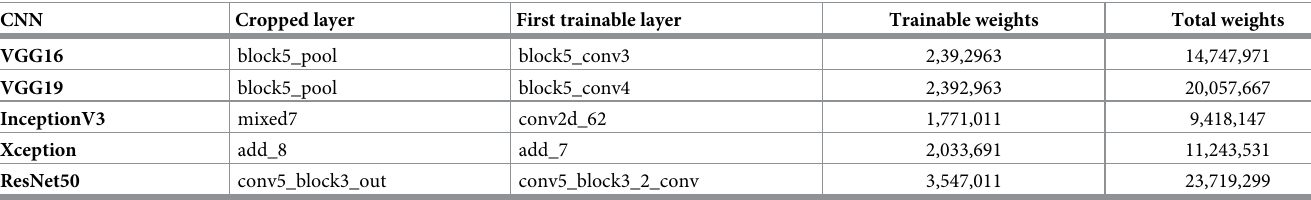
Table 1. CNN configurations considered for COVID-19 identification in LUS